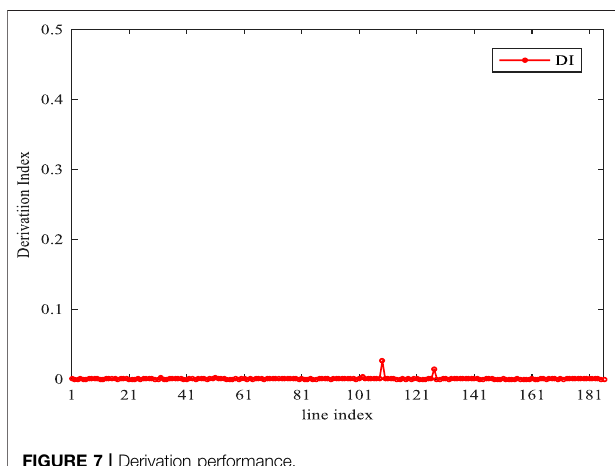
FIGURE 7 | Derivation performance.